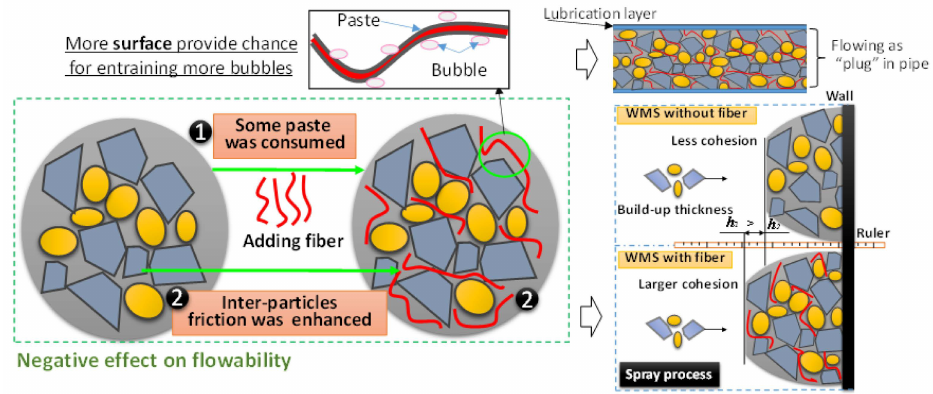
Figure 9. Schematic of fiber (FI) affecting the flowability, shootability, and air